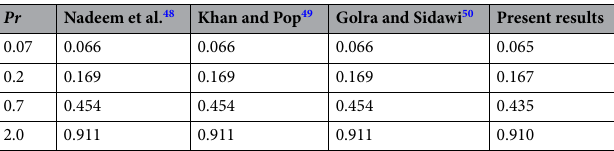
Table 1. The comparative outputs for